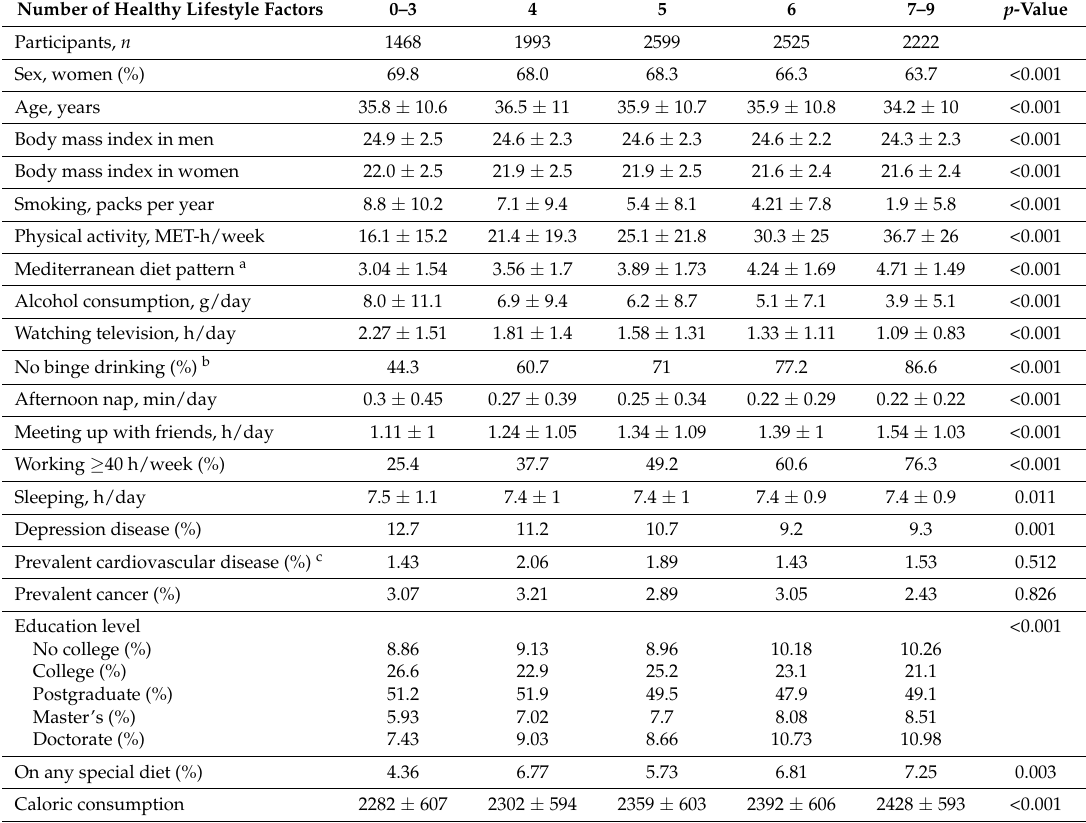
Table 2. Baseline characteristics of participants according to the number of Healthy Lifestyle Factors (HLFs) (the SUN cohort).